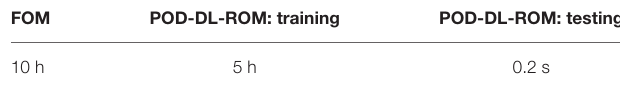
TABLE 3 | Test 2 : FOM and POD-DL-ROM computational times.